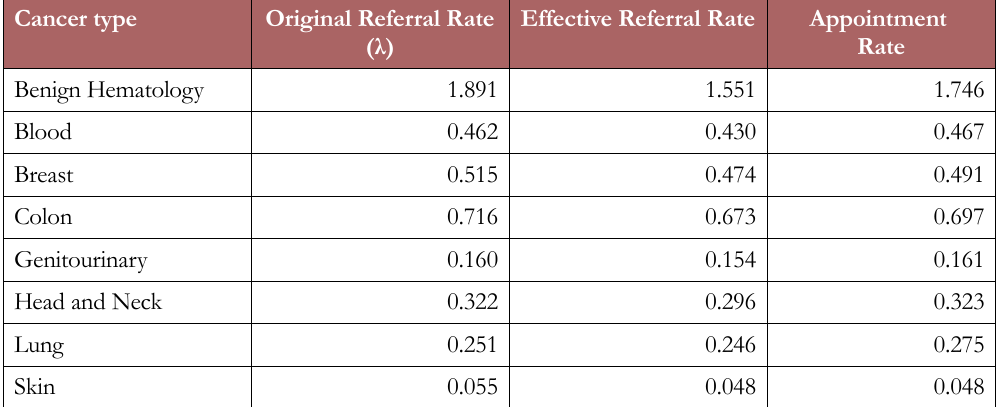
Table 4. New patient daily referral, effective, and appointment rates